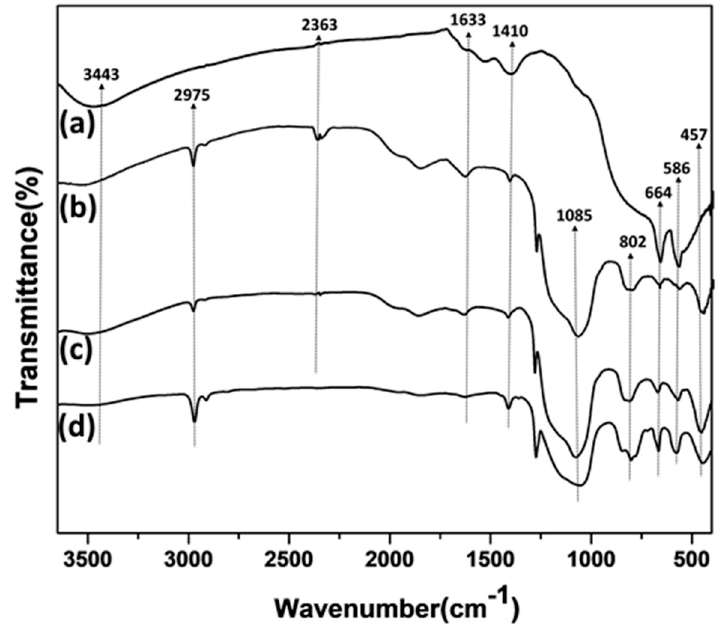
Figure 5. FTIR spectra of the ( a ) Co/Al 2 O 3 , ( b ) Co/NS-Al-A, ( c ) Co/NS-Al-B and ( d ) Co/NS catalysts.